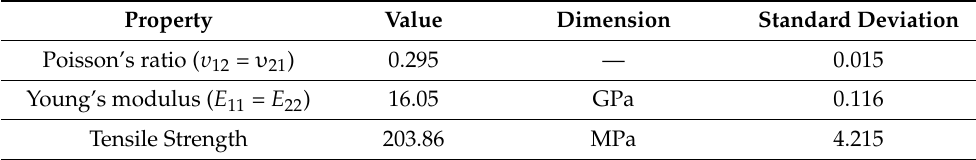
Table 1. Mechanical properties of woven GFRP composites.